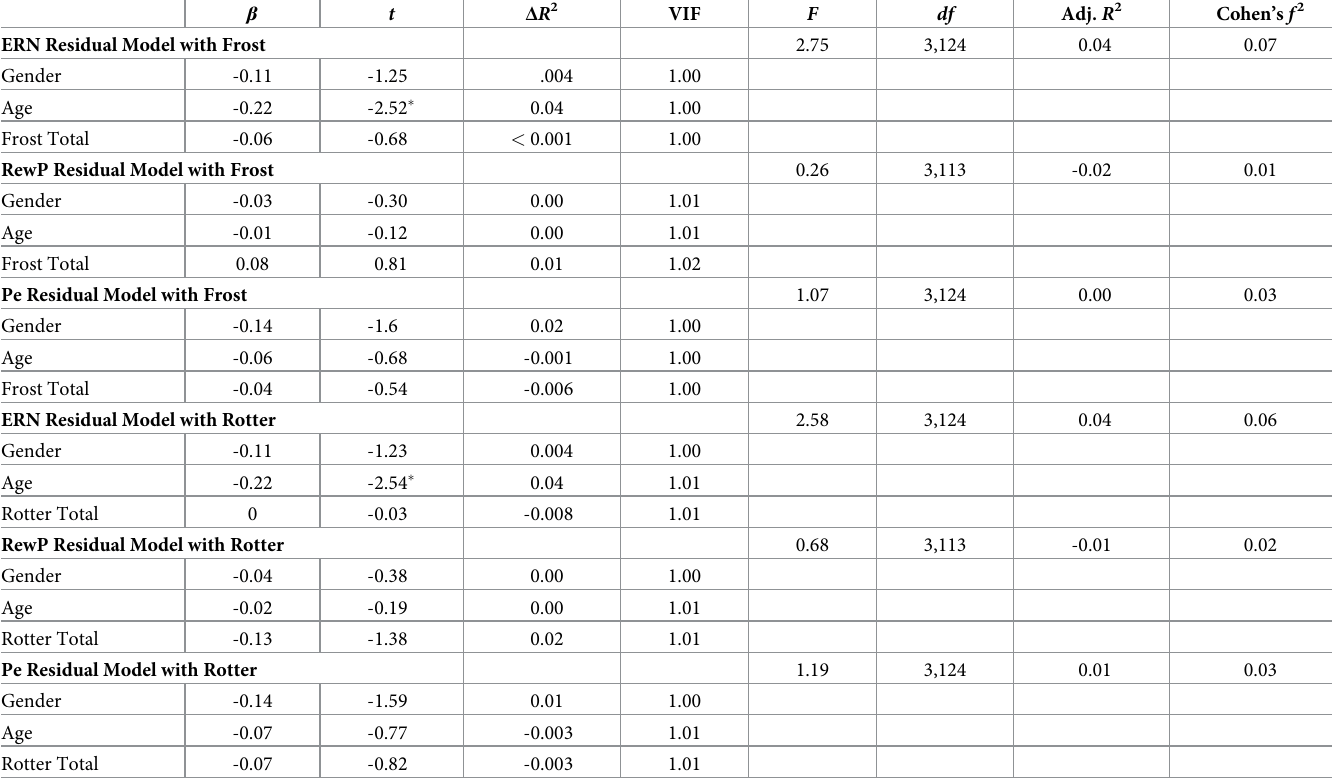
Table 5. Multiple linear regressions with Frost Perfectionism scale and Rotter locus of control scale predicting residual